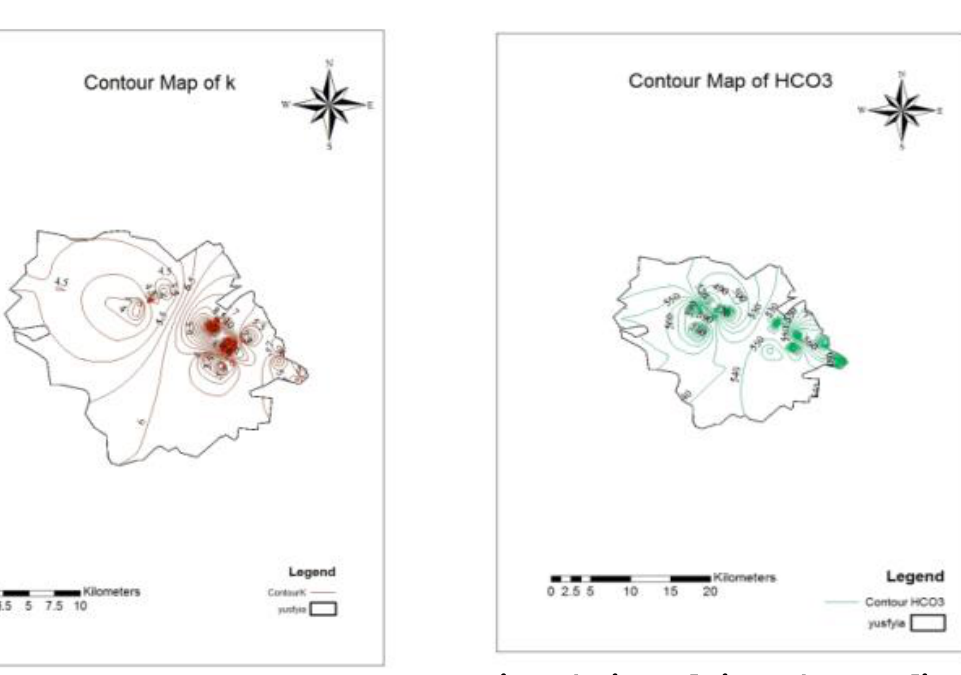
Fig.9: The interpolation and contour line of HCO map in 3